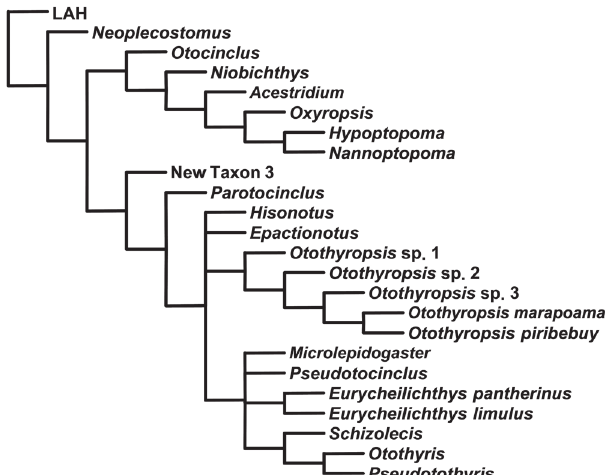
Fig. 2. Strict consensus tree depicting the phylogenetic relationships among genera of Hypoptopomatinae and species of Otothyropsis . Consensus based on six maximally parsimonious trees (primary trees with L = 118; CI = 50; RI = 73). Eurycheilichthys limulus represents New Taxon 1 and Epactionotus represents New Taxon 2 of the phylogeny in Schaefer